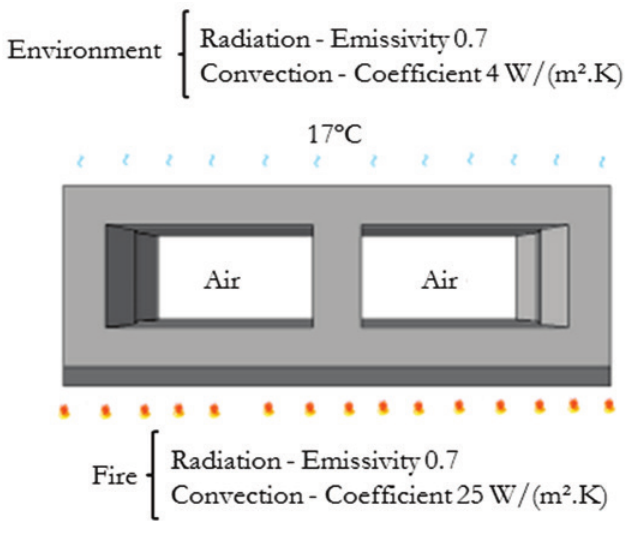
Specific heat variation of the concrete according to the moisture